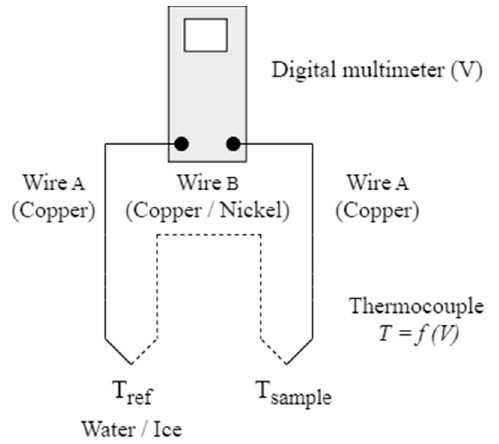
Figure 3. Type T thermocouple thermometer showing copper and copper-nickel (Constantan) ref- erence and sample junctions.